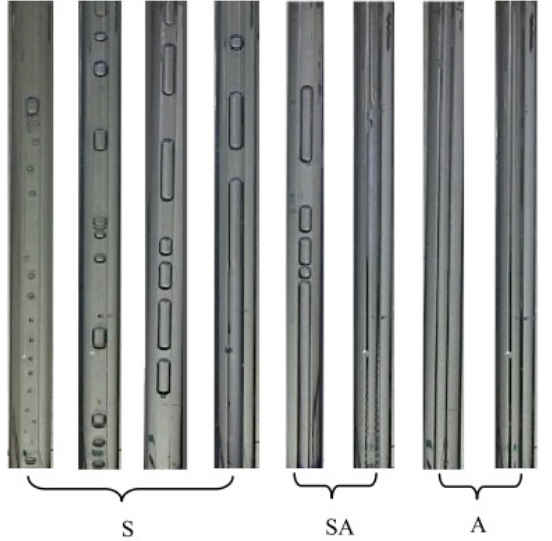
Figure 1. Flow patterns observed in the adiabatic section of a 1.6 mm ID PHP filled with ethanol during a series of experiments [9]. S: slug/plug; SA: semi-annular; A: annular.